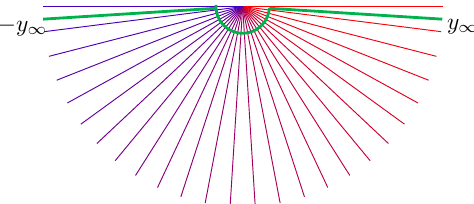
Figure 2 . We depict here the regularization in ( y; p ) plane of M (cid:15) . The regularization is de(cid:12)ned by the coordinate ranges y